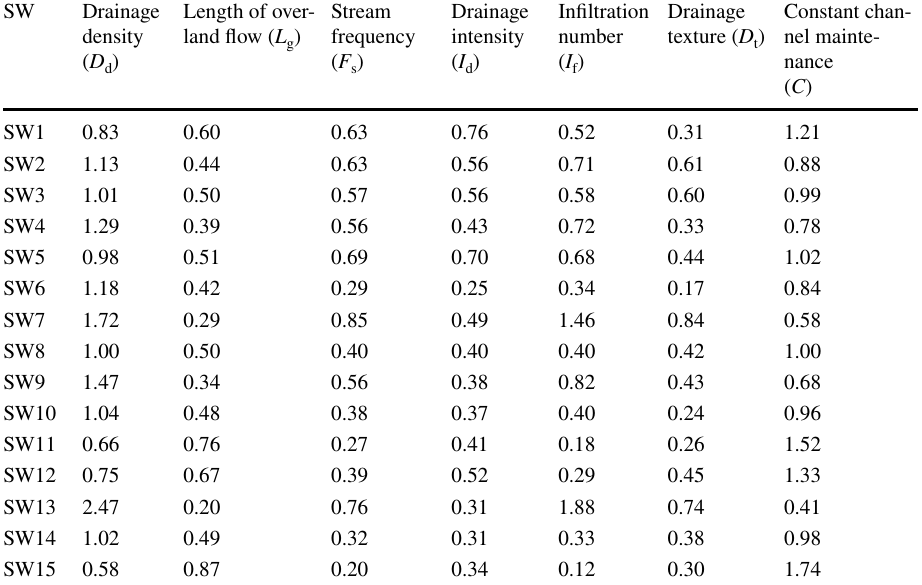
Table 5 Drainage parameters of the study